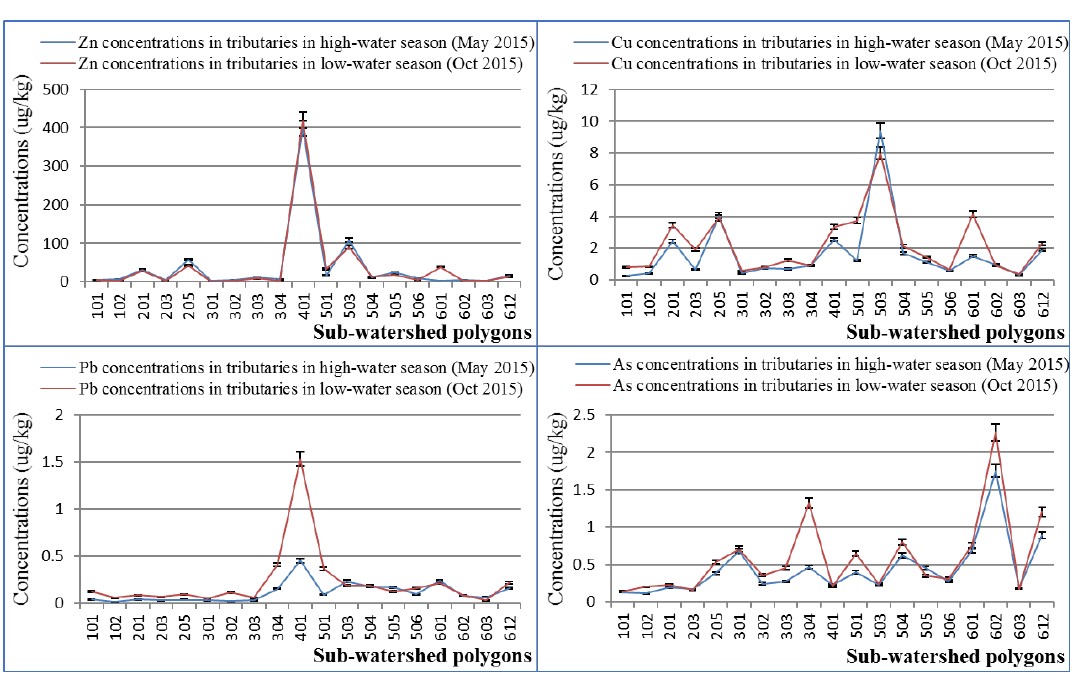
Figure 6. Zn, Cu, Pb and As concentrations in tributaries both in the high-water and low-water seasons. The error bar was plotted following the maximum allowable relative standard deviation of 5%, referring to the precision of the Standard Reference Material (SRM 1643e)